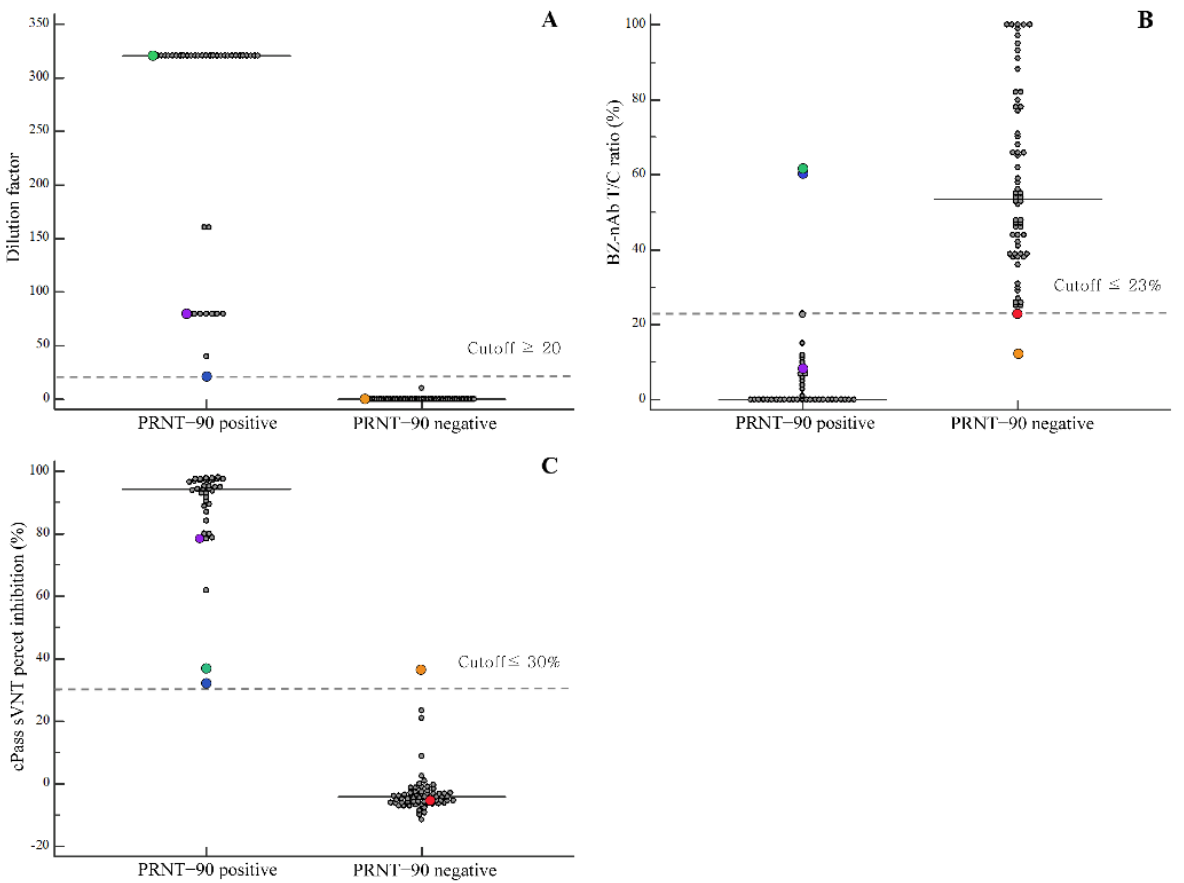
Figure 2. Data distribution and comparison between PRNT-90-positive and -negative groups. ( A ) PRNT-90 dilution factor; ( B ) BZ-nAb T/C ratio; ( C ) cPass sVNT percent inhibition. When compared with the PRNT-90 positive samples, the BZ-nAb showed three discordant results when visually interpreted (green, blue, purple dots), and two when interpreted using T/C ratio (green, blue dots). When compared with the PRNT-90 negative samples, the BZ-nAb showed two discordant results using T/C ratio (red, orange dots), and one discordant result was also noted with cPass sVNT (orange dot). The horizontal dashed lines indicate the cutoffs for each assay.